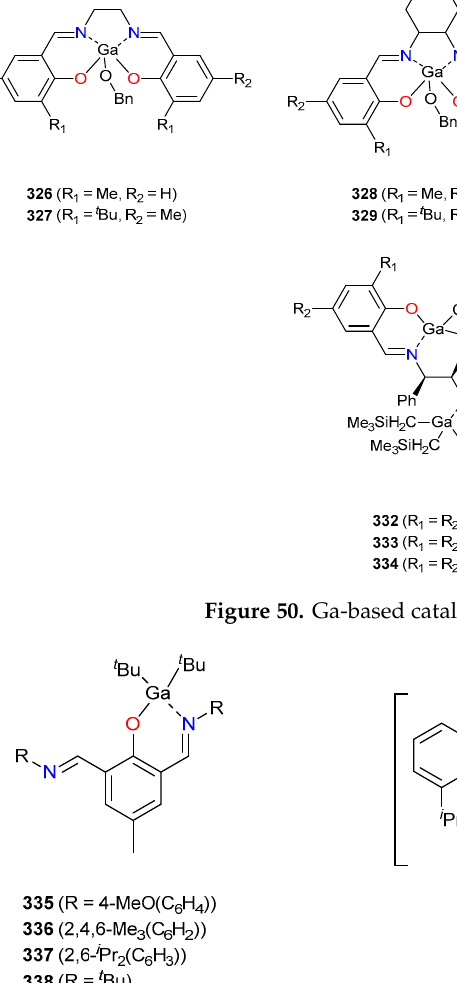
Figure 51. Bis(imino)phenoxide-based Ga complexes [143].